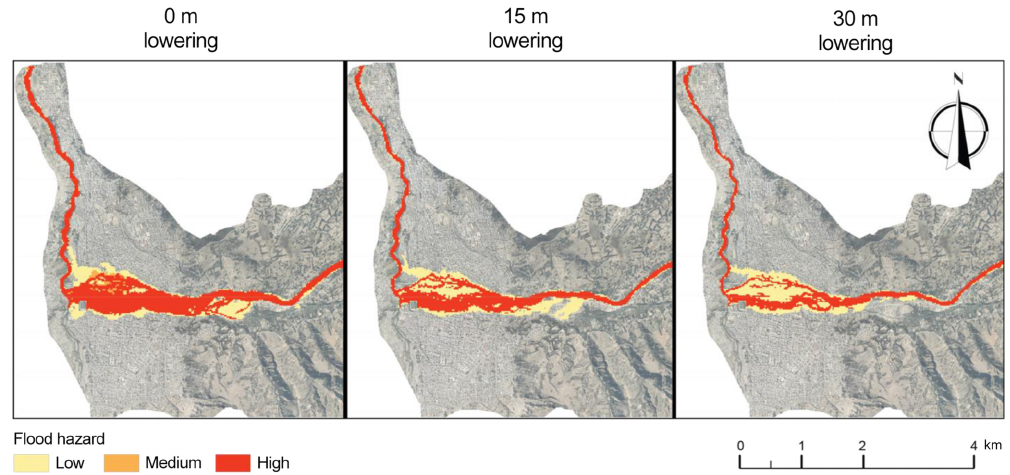
Figure 3. This image corresponds to Fig. 9 from Somos-Valenzuela et al. (2016). Preliminary hazard map of Huaraz due to a potential GLOF originating from Lake Palcacocha with the lake at its current level (0m lowering) and for the two mitigation scenarios (15 and 30m lowering).